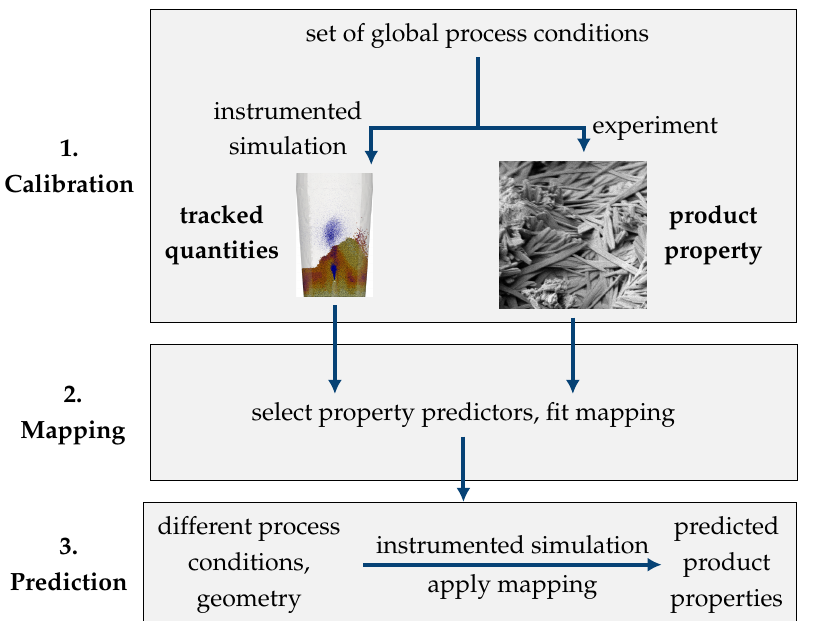
Figure 1. Schematic of the proposed approach to correlate the tracked quantity with product